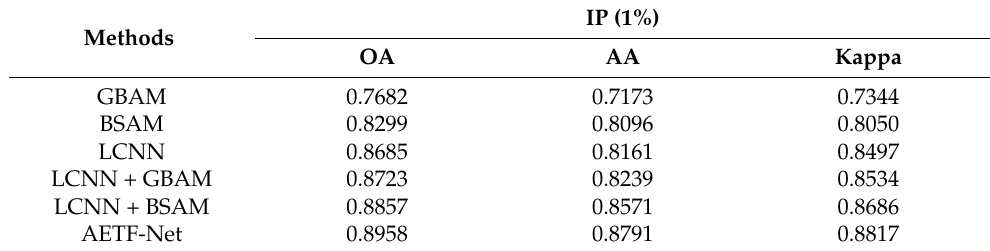
Table 8. The best ablation study results on the IP dataset.